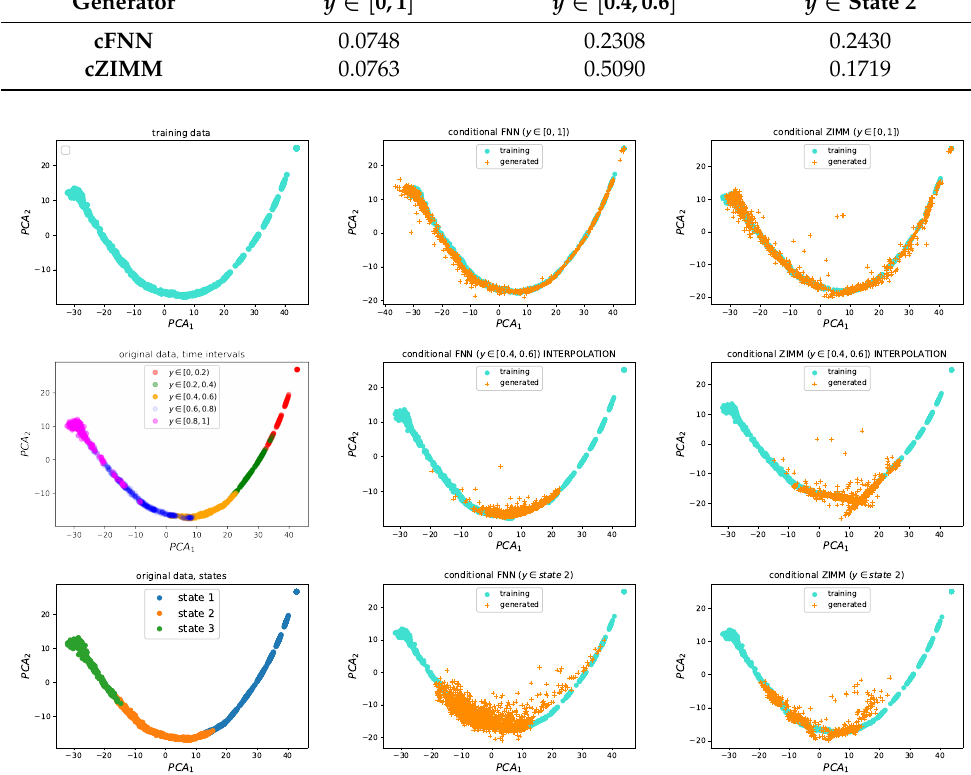
Figure 4. Synthetic 50-dimensional data set with zero-inflated modes. First two PCA components visualization of real over generated data, colored in turquoise and orange respectively. ( upper row ) Training data with uniformly chosen labels y ∈ [ 0,1 ] . Conditional FNN shown in the middle is a better fit in comparison to the conditional ZIMM model on the right, at the cost of interpretability. Detailed histograms over all 50 genes (distribution marginals), can be found in the Supplementary Figure S13. ( middle row ) Training data colored according to pseudo-time label y (continuous) is shown on the left, where all five intervals have similar sample sizes. Training is performed on data with condition y ∈ [ 0,0.4 ] ∪ [ 0.6,1.0 ] (turquoise) whereas we generate data with y ∈ [ 0.4,0.6 ] (orange). Interpolation to unseen data is more accurate when the conditional FNN generator is used though conditional ZIMM is capable of identifying a significant part of the test set. ( lower row ) Training data colored according to differentiation state label y (discrete) is shown on the left. Conditional FNN (middle) and conditional ZIMM (right), using a subpopulation of 5% of samples from state 2. The latter is important because this discrete condition does not provide dynamical information for